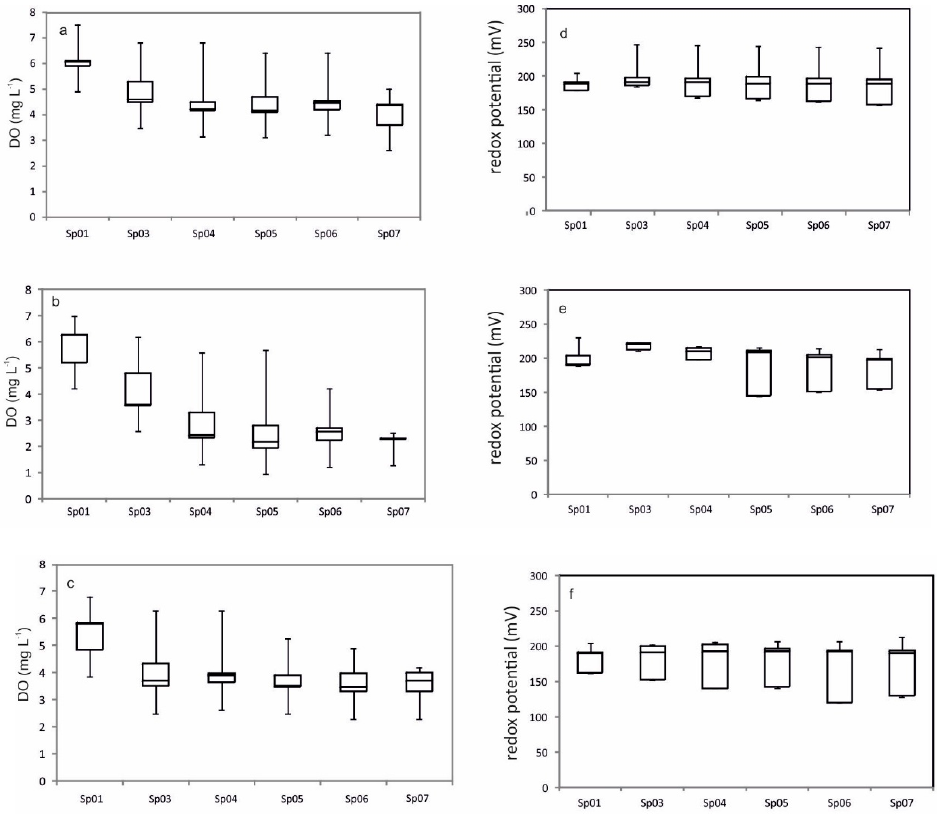
Figure 5. Box plot representation of the data obtained in the analysis of the vertical concentration profiles of dissolved oxygen (DO) and redox potential inside the three filters (( a , d )—reference filter; ( b , e )—CIM filter; ( c , f )—ICS filter).